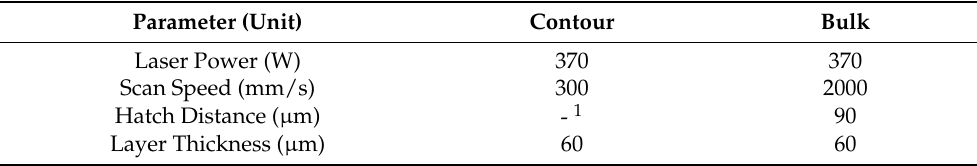
Table 2. LPBF process parameters as used for sample contour and bulk in the present